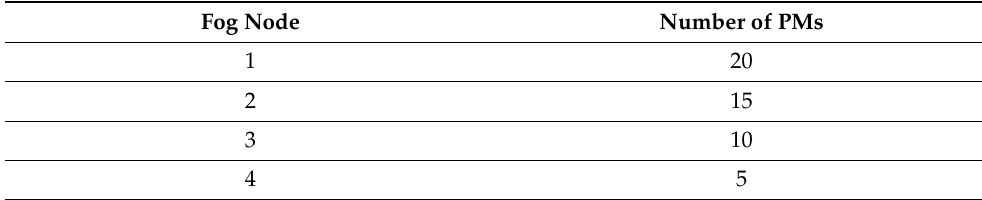
Table 3. Number of PMs in each Fog Node.